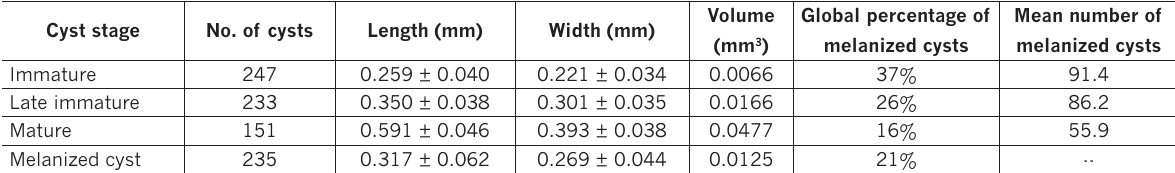
Table 2. Mean length and width measurements and the volume (mm 3 ) of encysted metacercariae of Microphallus nicolli by devel- opment stage. Global percentage of melanized cysts corresponds to the sum of the percentages found in the three